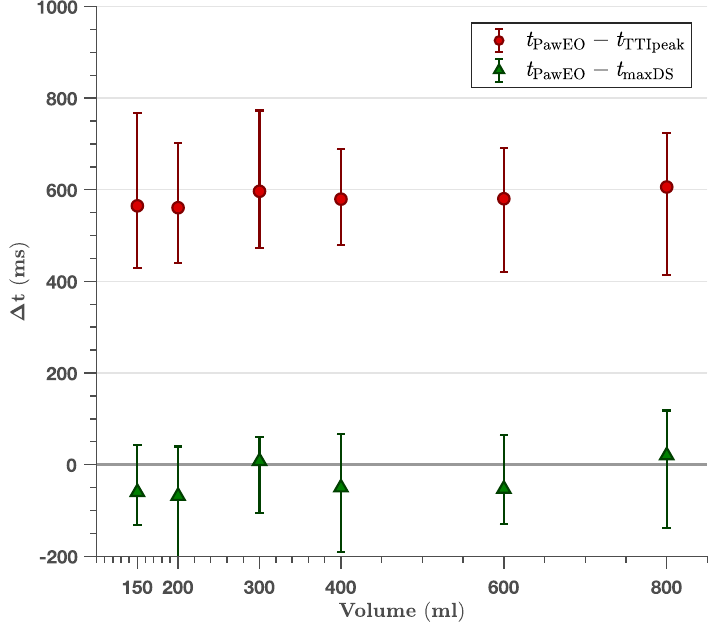
Figure 2. Effect of volume on the time differences between the TTI fiducial points (TTI peak, t TTIpeak , and maximum downslope, t maxDS ) and the peak pressure time in the Paw line marking exhalation onset ( t PawEO ). All ventilator settings had a constant frequency of 12min − 1 . Data is shown as median with first to third quartile interval. Time differences were independent of volume ( R 2 < 0.01 for the linear fit), and were around 0.5s for TTI peak and around 0s for maximum